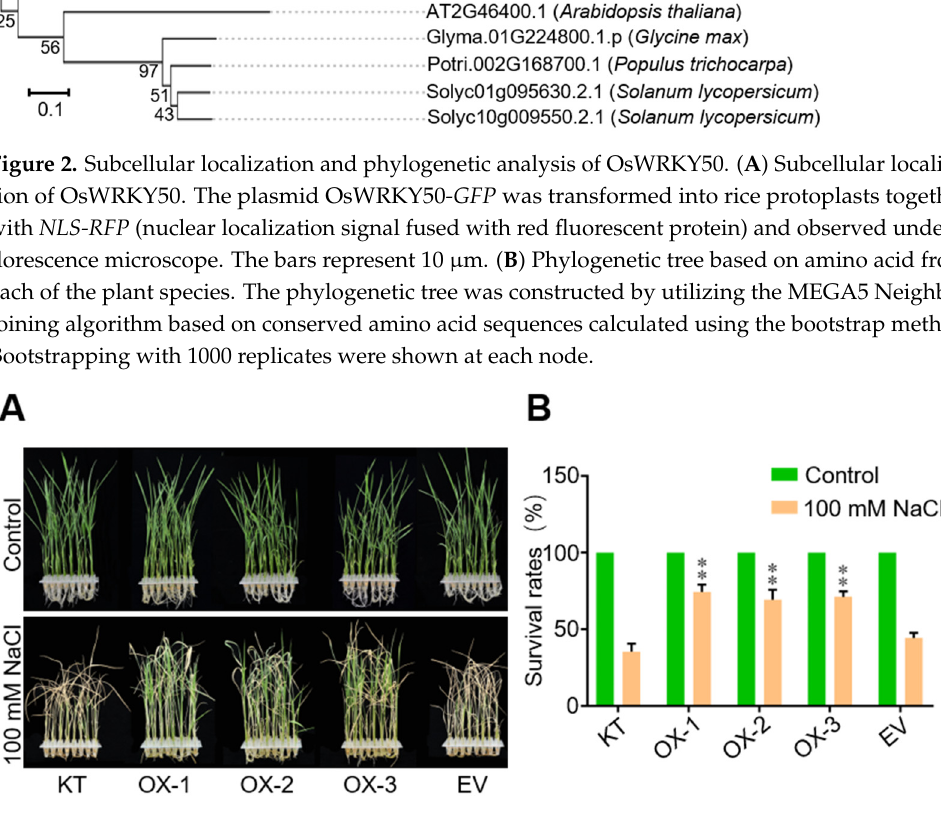
Figure 2. Subcellular localization and phylogenetic analysis of OsWRKY50. ( A ) Subcellular locali ‐ zation of OsWRKY50. The plasmid OsWRKY50 ‐ GFP was transformed into rice protoplasts together with NLS ‐ RFP (nuclear localization signal fused with red fluorescent protein) and observed under a florescence microscope. The bars represent 10 μ m. ( B ) Phylogenetic tree based on amino acid from each of the plant species. The phylogenetic tree was constructed by utilizing the MEGA5 Neighbor Joining algorithm based on conserved amino acid sequences calculated using the bootstrap method. Bootstrapping with 1000 replicates were shown at each node.